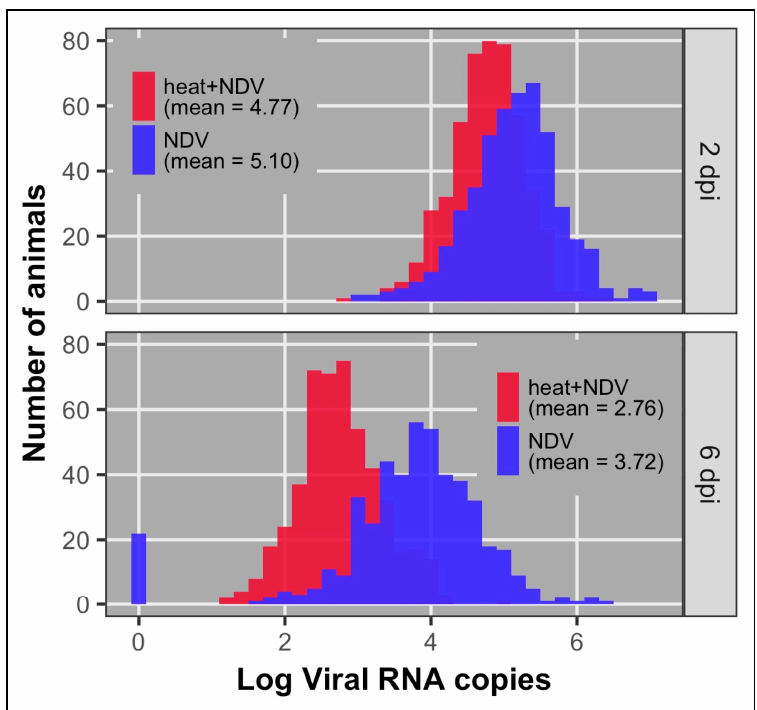
Figure 2. Viral load distributions at 2 and 6 dpi for both treatment groups.